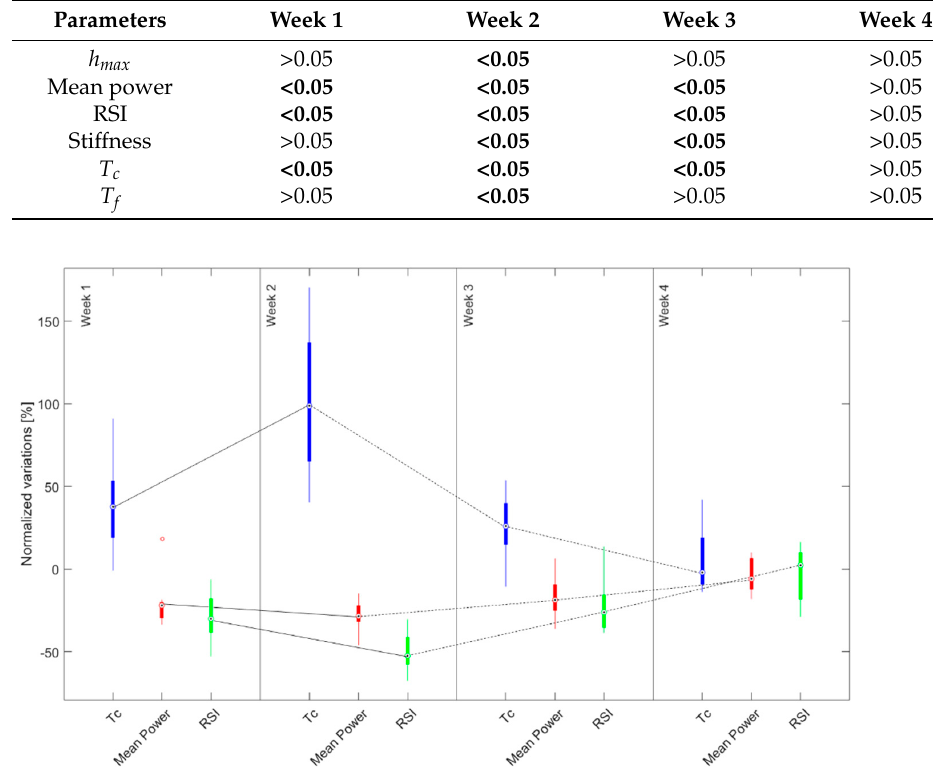
Figure 4. Boxplots of the parameters that were significantly influenced by the fatiguing protocol in the Bosco test. Dashed lines indicate an increased median performance, while solid lines indicate a decreased one.